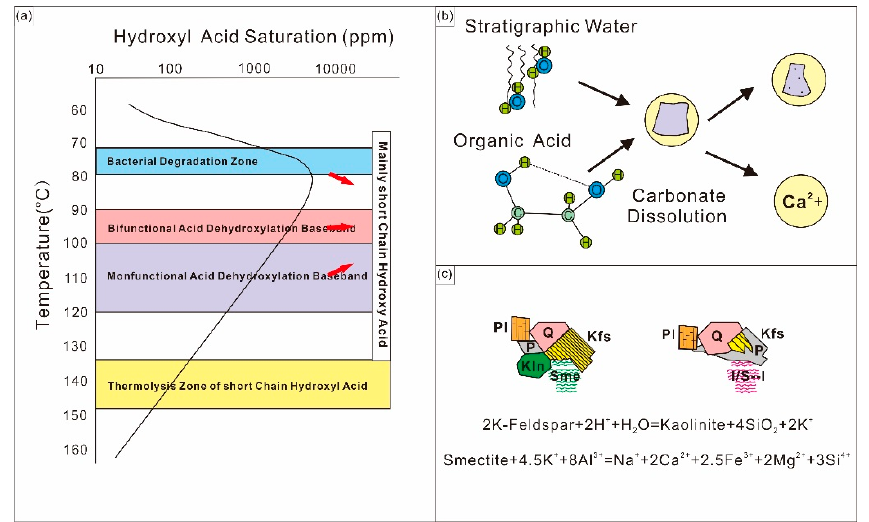
Figure 8. Diagenetic influences on different laminae. ( a ) the variation of hydroxyl acid saturation at different temperature, ( b ) the reaction between carbonate minerals and organic acid; ( c ) the process of transforming from montmorillonite to illite.